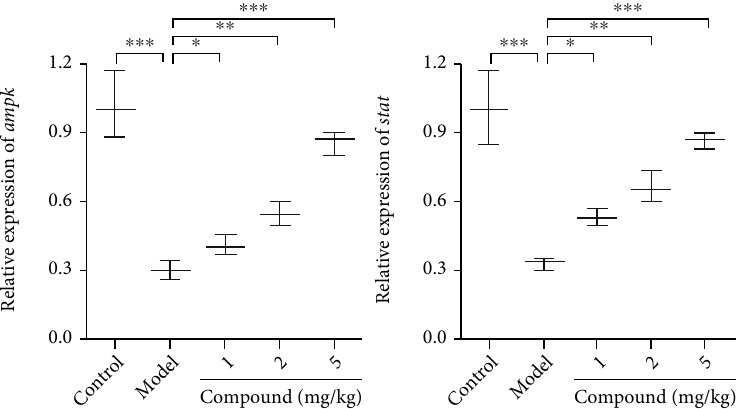
Figure 5: Obviously inhibited activation of AMPK in fl ammatory signaling pathway later than compound treatment. The LPS was injected into the mice to induce the foot and ankle arthritis animal example, and then, complex was disposed at the concentration of 1, 2, and 5 mg/ kg. AMPK in fl ammatory signaling pathway was also determined with real-time RT-PCR.